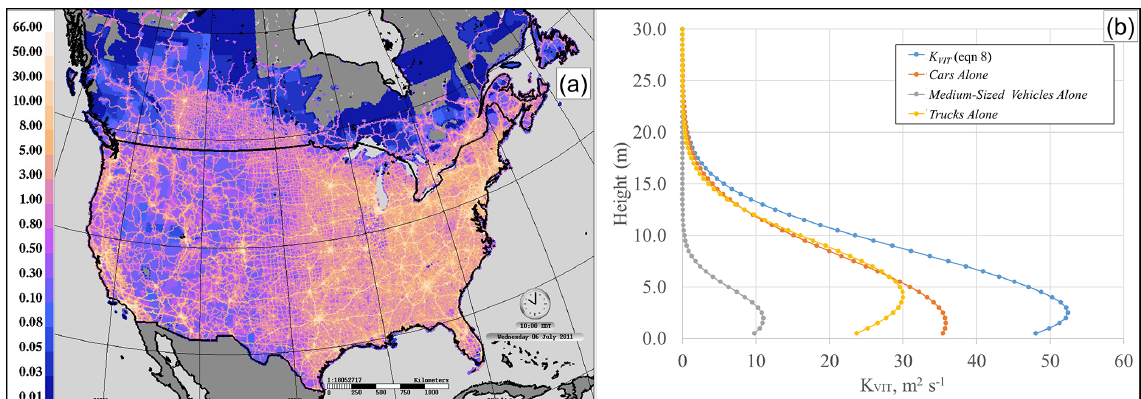
Figure 4. (a) Example estimated thermal turbulent transfer coefficients from VIT at 2m elevation during a weekday at 10:00 in July (m 2 s − 1 ), using the VKT data of Fig. 3. (b) Vertical profile of VIT thermal turbulent transfer coefficients at 1m resolution in central Manhattan Island and individual values for the TKE associated with cars, mid-sized vehicles, and trucks considered separately, generated using Eq. (8). Note that the profiles of (b) would be added to the ambient thermal diffusivity coefficients (see Sect. 2.5 and Eq.